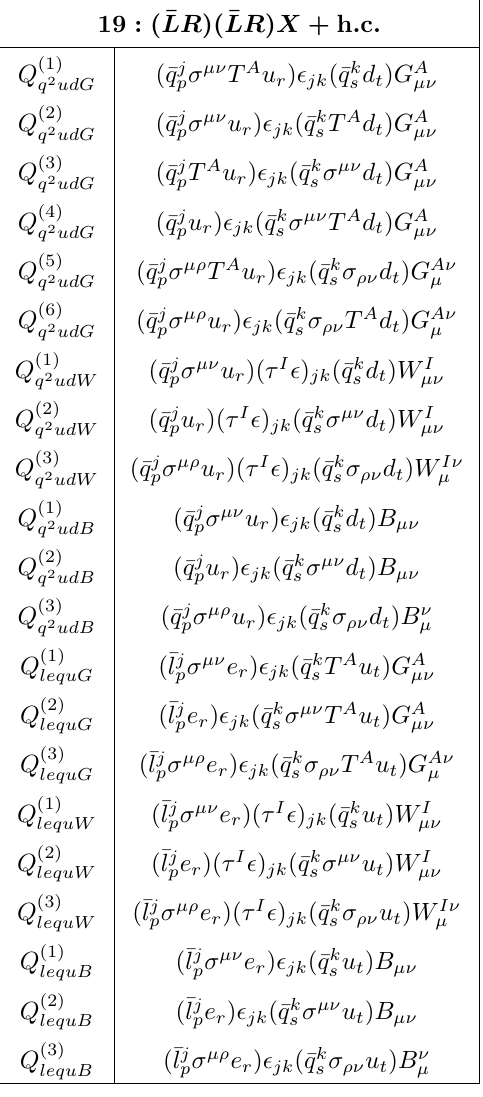
Table 14 . The dimension-eight operators in the SMEFT of class-19 with (cid:12)eld content ((cid:22) LR )( (cid:22) RL ) X or ((cid:22) LR )((cid:22) LR ) X . All of the operators have Hermitian conjugates. The subscripts p; r; s; t are weak- eigenstate